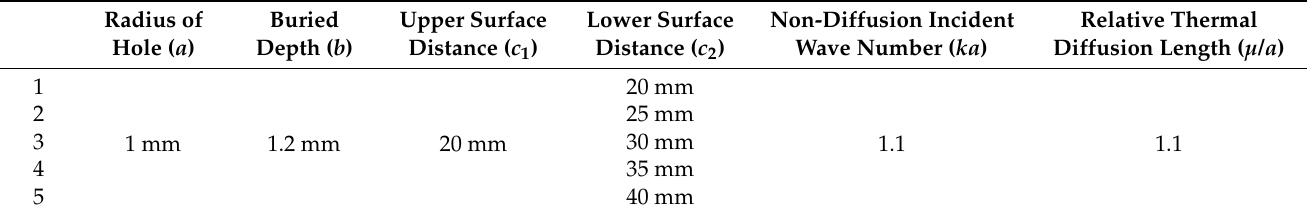
Figure 5. Influence of the distance from the circular through hole to the upper and lower surfaces of the Pt–Rh bushing on the temperature distribution in the Y -axis direction. As shown in Table 3, the distance between the circular through hole and the lower surfaces of the platinum-rhodium bushing is c 2 = 20 mm, 25 mm, 30 mm, 35 mm, and 40 mm, respectively. The surface temperature distribution diagram shown in Figure 6 and the “ y - | ϑ | ” diagram shown in Figure 7 can be obtained by ANSYS and MATLAB. Table 3. Parameters of circular hole and incident light source in the second